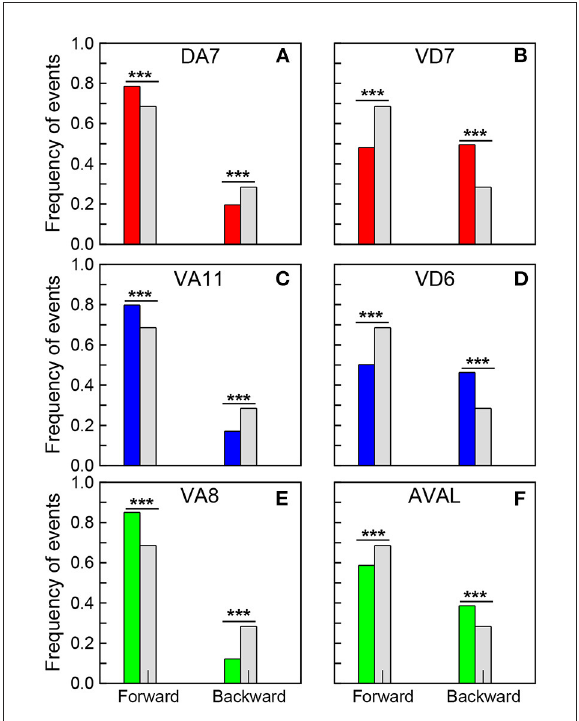
FIGURE5 Correlation of neural dynamics with robot actions. Fraction of forward and backward events registered when the selected neurons fired. (A) DA7, (C) VA11, and (E) VA8 correspond to the neurons with the largest positive PC1 in the synchronized clusters (cid:127) 1 , (cid:127) 2 and (cid:127) 3 , while (B) VD7, (D) VD6, and (F) AVAL correspond to the neurons with the lowest negative PC1 in these clusters. The gray bars correspond to the fraction of forward and backward events in a 20 min long experiment. A chi-square test (statistically significant, *** p -value < 0.00001) show that the opposing effects of all these neurons in the actions of the robot are